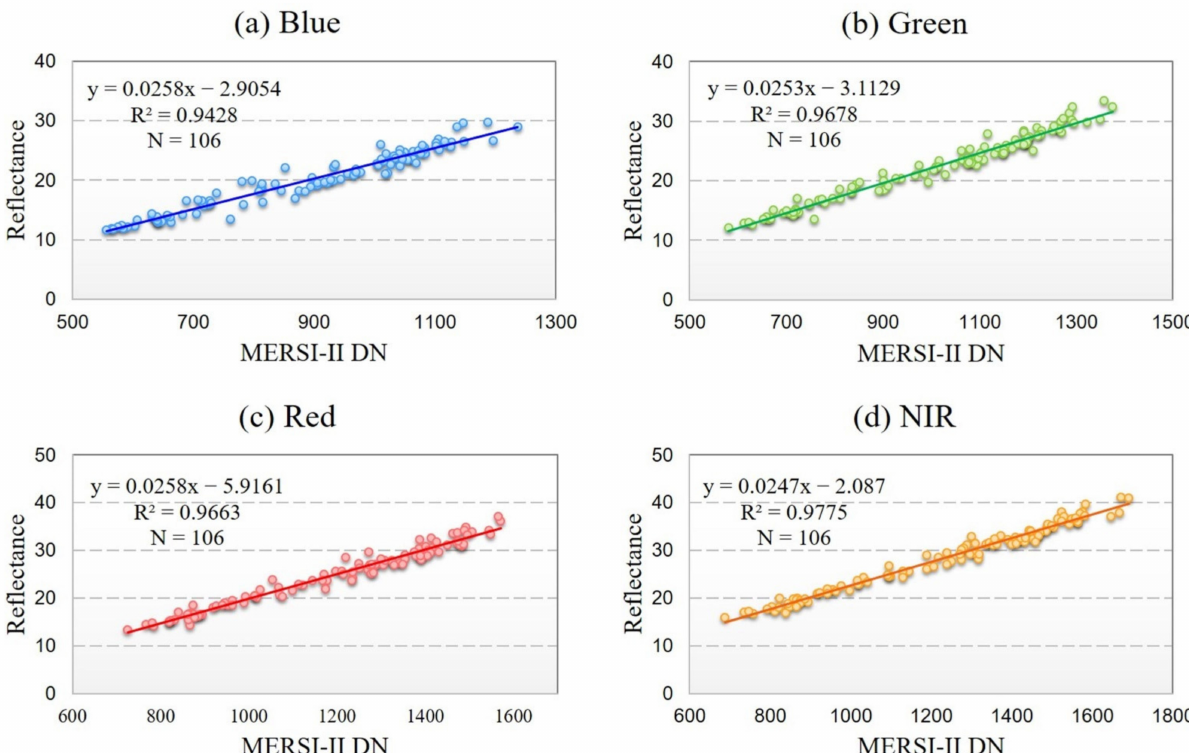
Figure 7. The relationships between in-situ measurements simulated at-sensor reflectance and DNs of FY-3D MERSI-II for the four spectral bands using the reflectance-based method with BRDF correction: ( a ) blue band; ( b ) green band; ( c ) red band; ( d ) NIR band. Least-squares linear fitting resulted in vicarious calibration